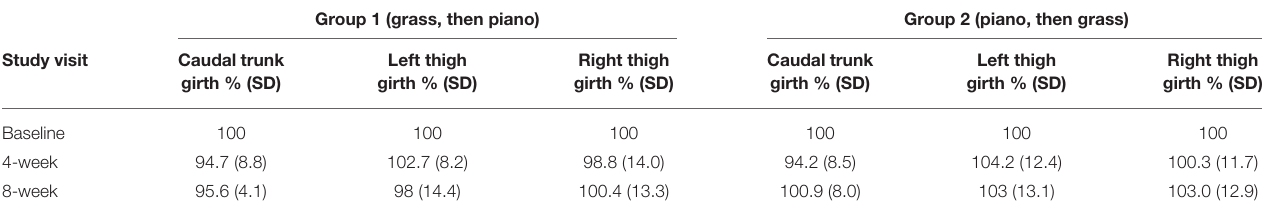
TABLE 2 | Mean thigh and body girth measurements at the 4- and 8-week study visits, expressed as a percentage of baseline values. Group 1 (grass, then piano)